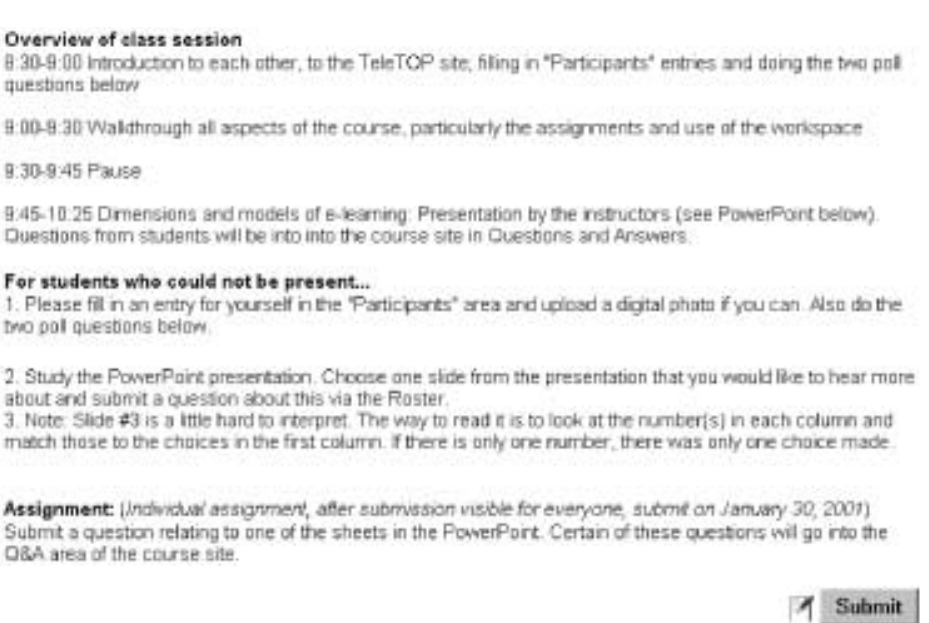
Figure 6. Example of flexibility in pedagogic approach related to attending a